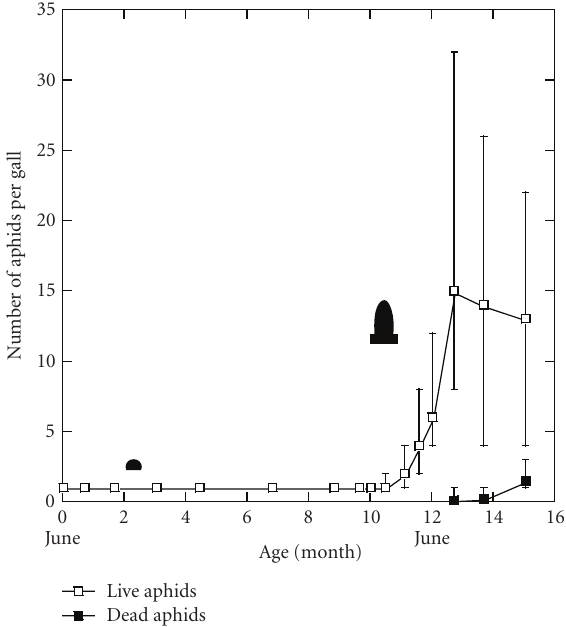
Figure 3: Colony development in galls of Nipponaphis monzeni for the first 15 months. Vertical lines indicate the range for the number of aphids per gall. The sample sizes are 20, 17, 20, 21, 13, 20, 15, 17, 23, 25, 17, 29, 20, 13, 9, and 20 from the left to right. The ages are calculated based on the assumption that all galls were initiated on 15